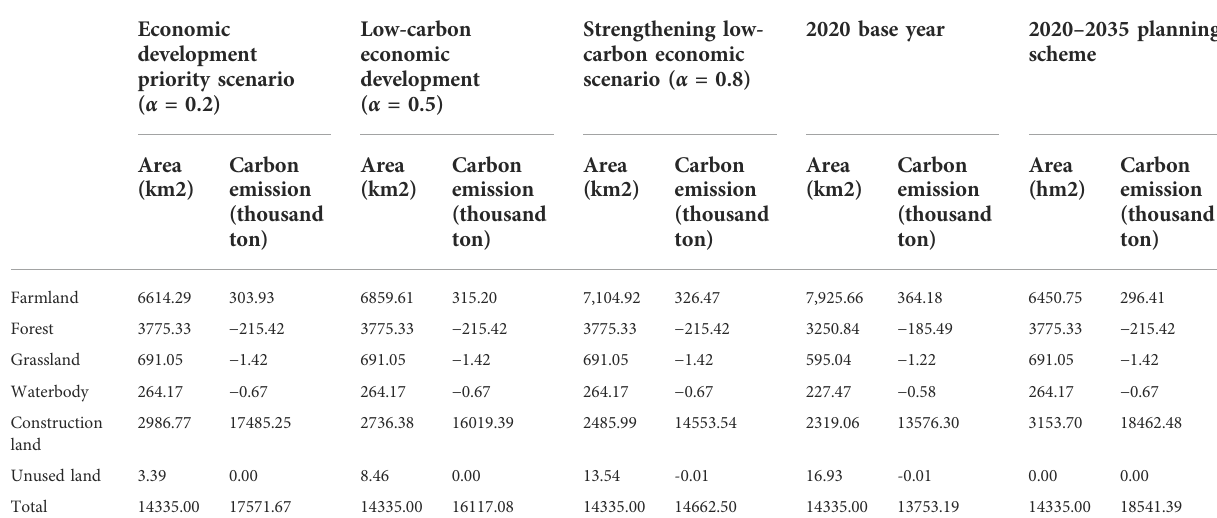
TABLE 4 Optimization results of land use